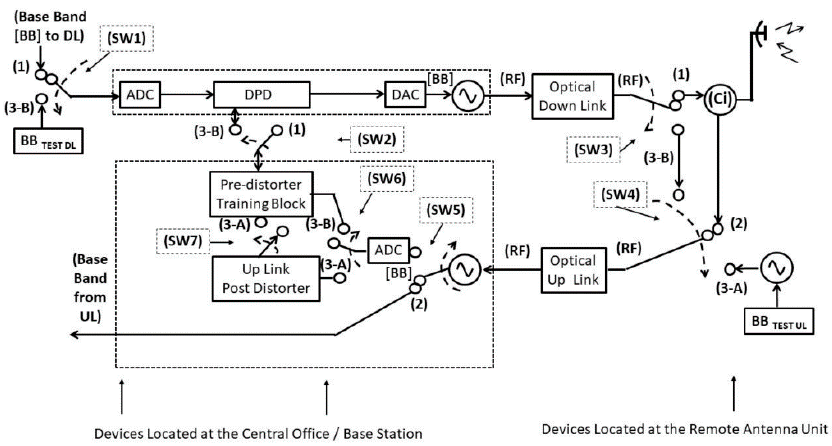
Figure 11. Possible realization of an adaptive predistortion scheme.